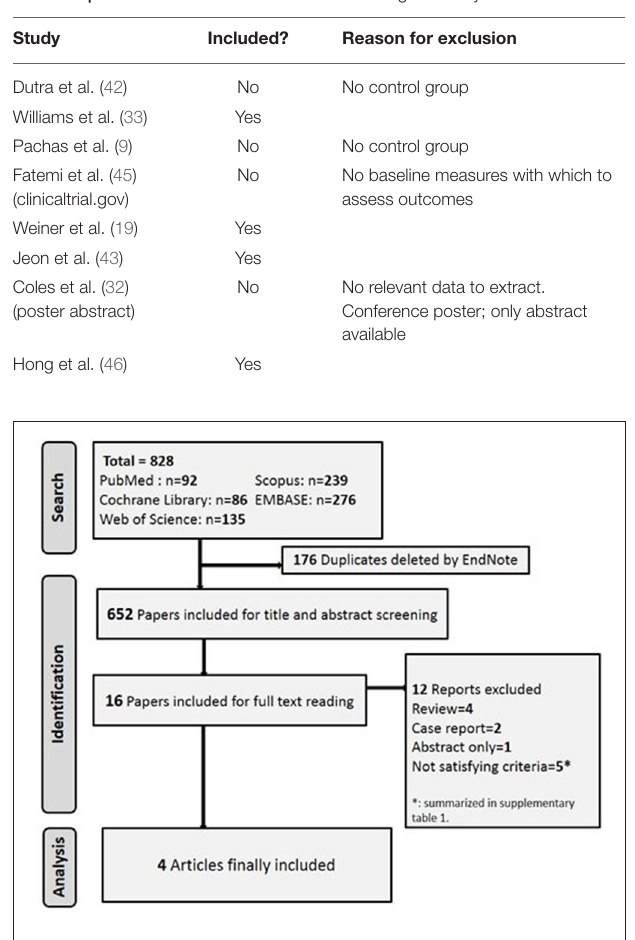
FIGURE 1 | PRISMA flow diagram of studies’ selection and